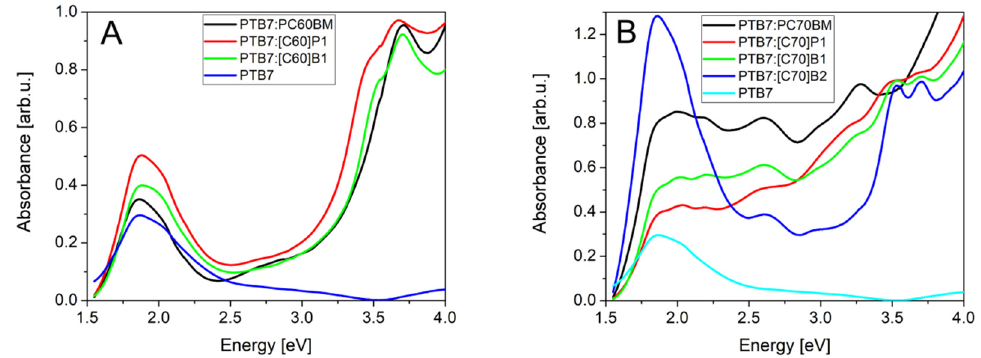
Figure 7. Absorption spectra of PTB7: fullerene derivatives: ( A ) C 60 , ( B ) C 70 .